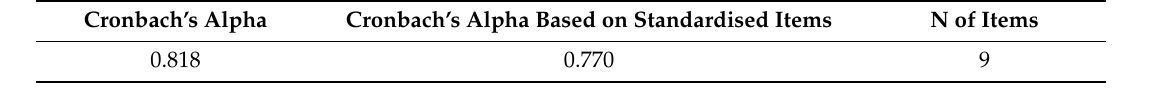
Table 5. Reliability